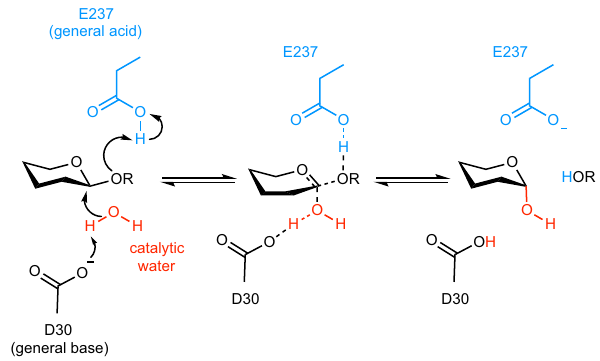
Fig. 1 General reaction mechanism of inverting GH43 enzymes. Residues numbers correspond to the enzyme under